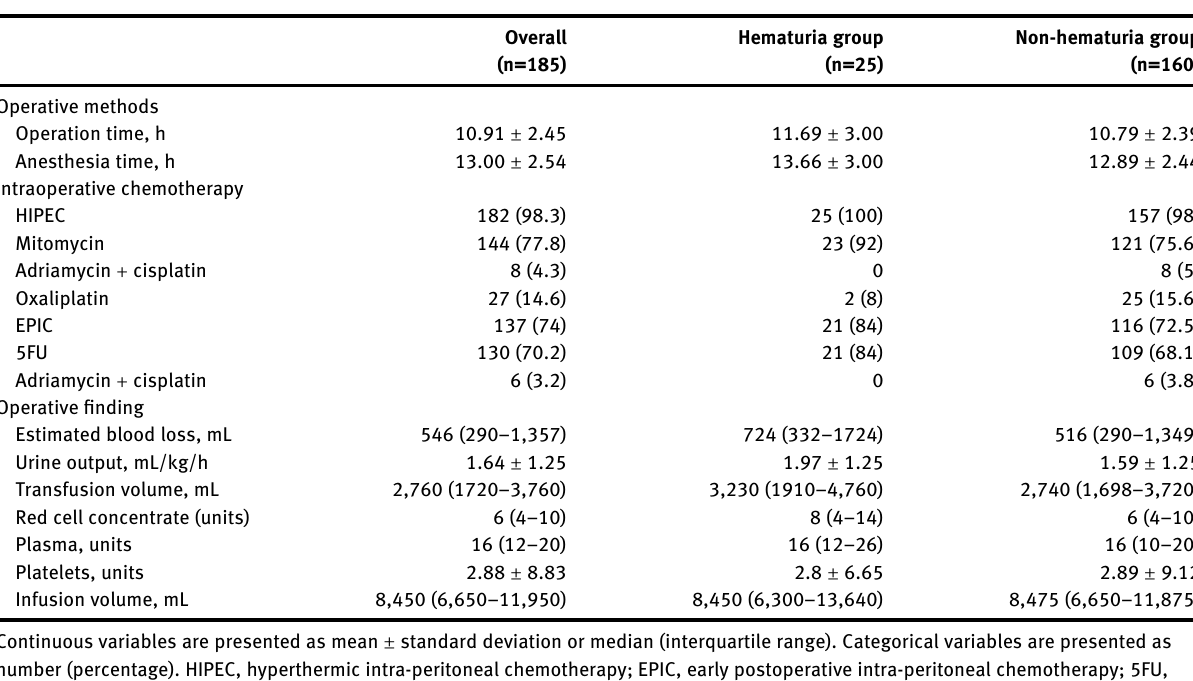
Table  : Operation data.